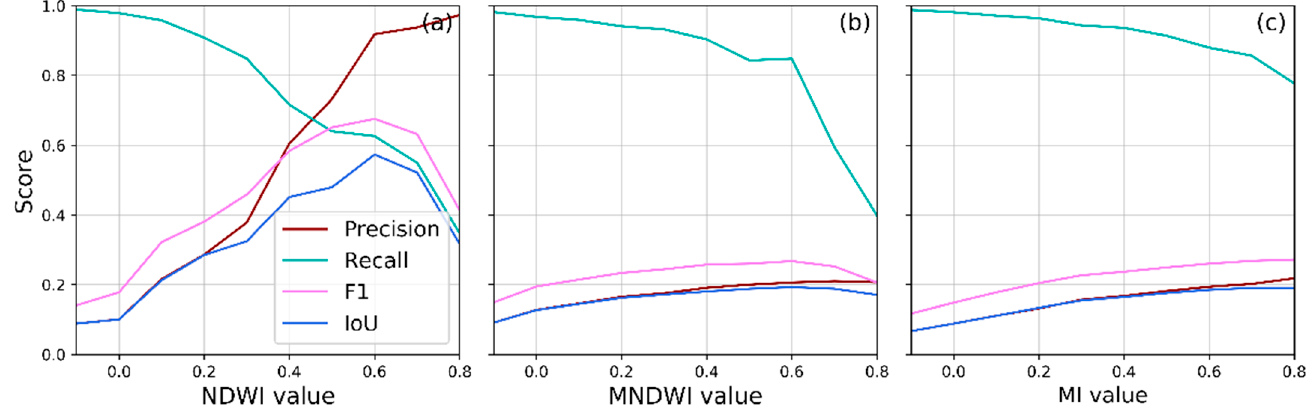
Figure 5. The effects between thresholds and evaluation metrics on the NDWI, MNDWI and MI, respectively. ( a ) Threshold ablation for NDWI. We set 0.6 of the NDWI threshold for further experiments as it can balance the lake information and noise information. ( b ) Threshold ablation for MNDWI. The best threshold of MNDWI should be 0.6 for providing pseudo lake masks. ( c ) Threshold ablation for MI. The best threshold of MNDWI should be 0.7 for providing pseudo lake masks.